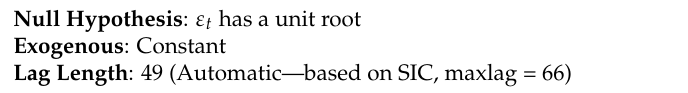
Table 5. Augmented Dickey–Fuller test results applied to residuals from Equation